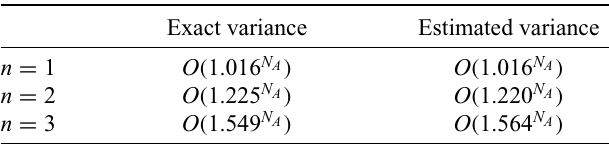
TABLE II. Exact dependence of the variance on system size for the toric code model as calculated by the transfer matrix method compared to the variance estimated from sampling of the expressions in Eqs. (34) and